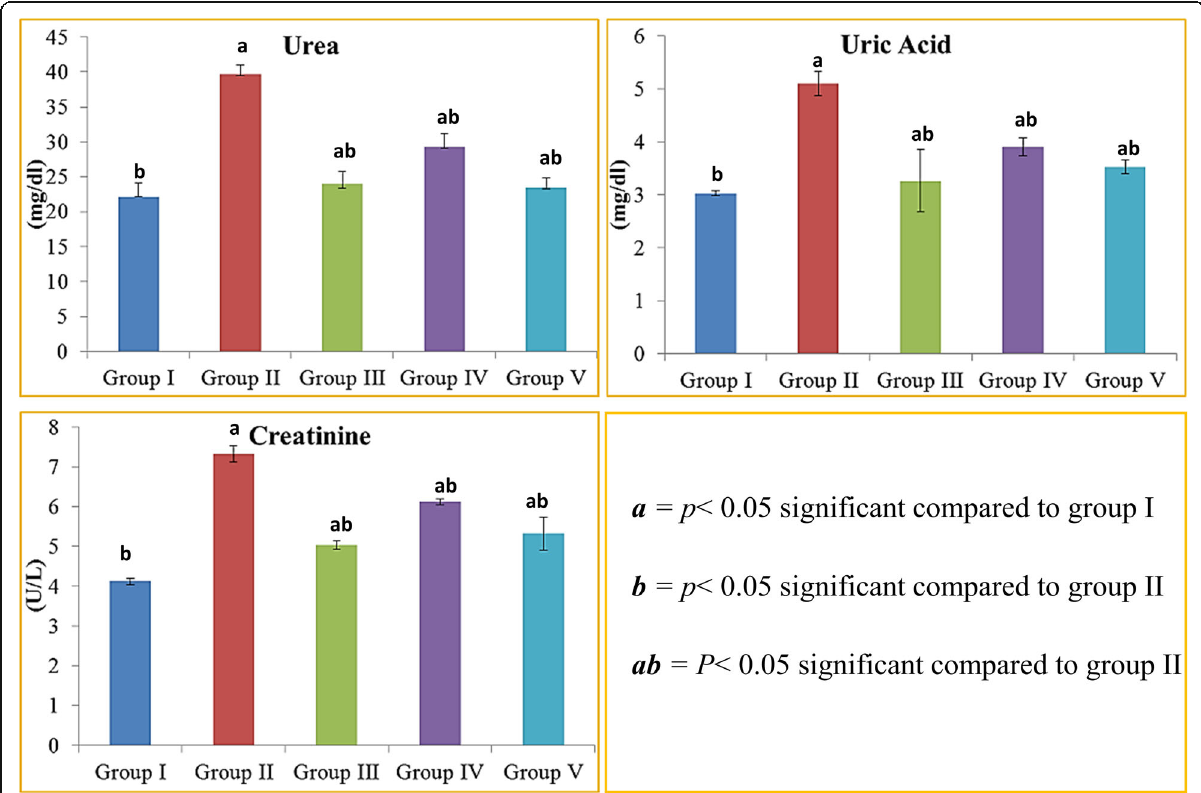
Fig. 6 ( a - c ) Effect of ethanolic extract of T. chebula on serum biochemical parameters responsible for monitoring the toxicity associated with the proper functioning of the kidney. Values are expressed as mean ± S.D. Statistical significance ( p ) was calculated by one-way ANOVA followed by Tukey ’ s multiple comparison test. P < 0.05 were considered